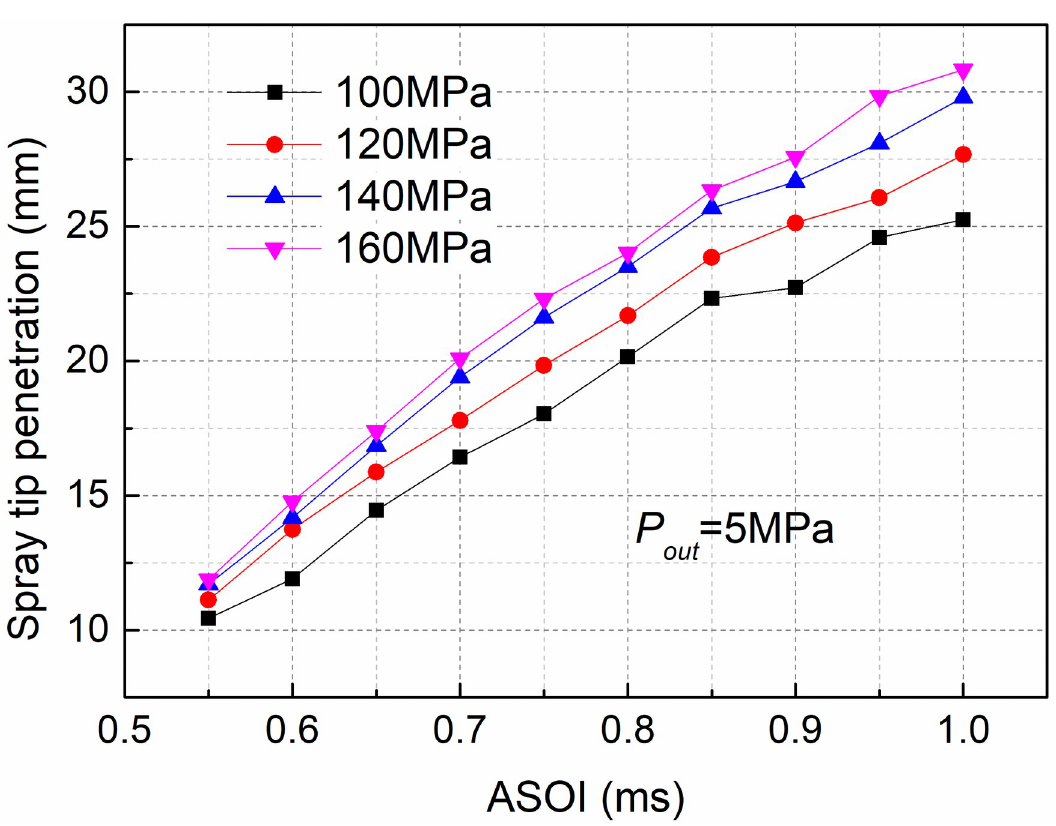
Fig 9. Spray tip penetration at various P in and fixed P out of